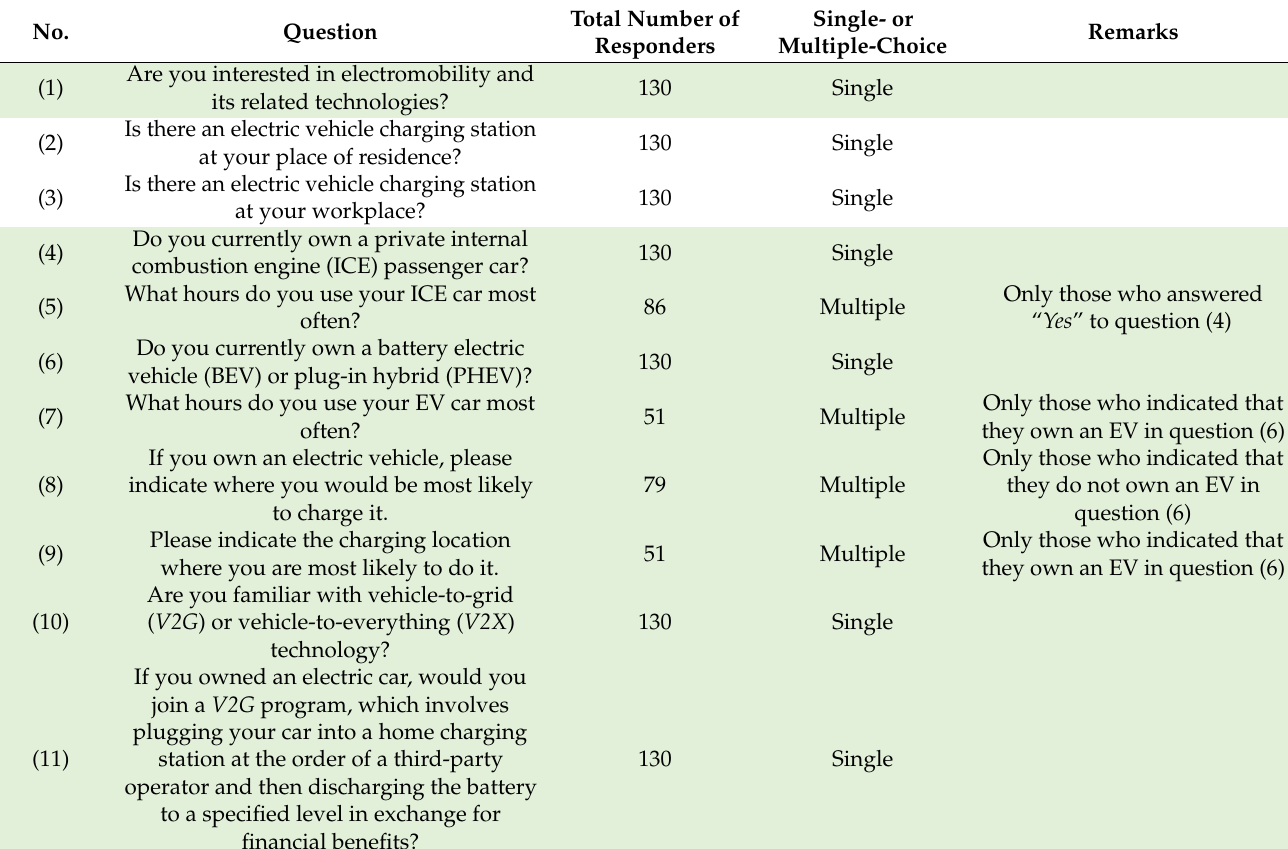
Table A1. Questions posed in the